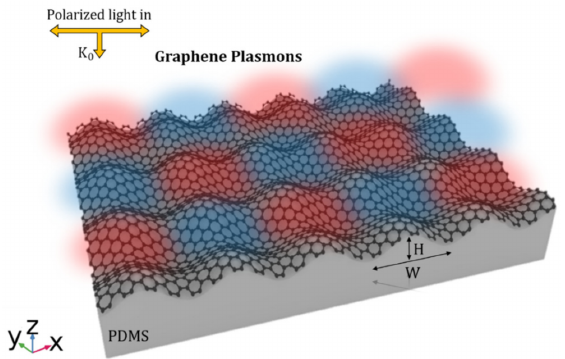
Figure 1. Schematic demonstration of a biaxially crumpled graphene structure with crumple width W and crumple height H. Polarized light with electric field E along the crumpling directions x and y illuminates in the normal direction K 0 to the